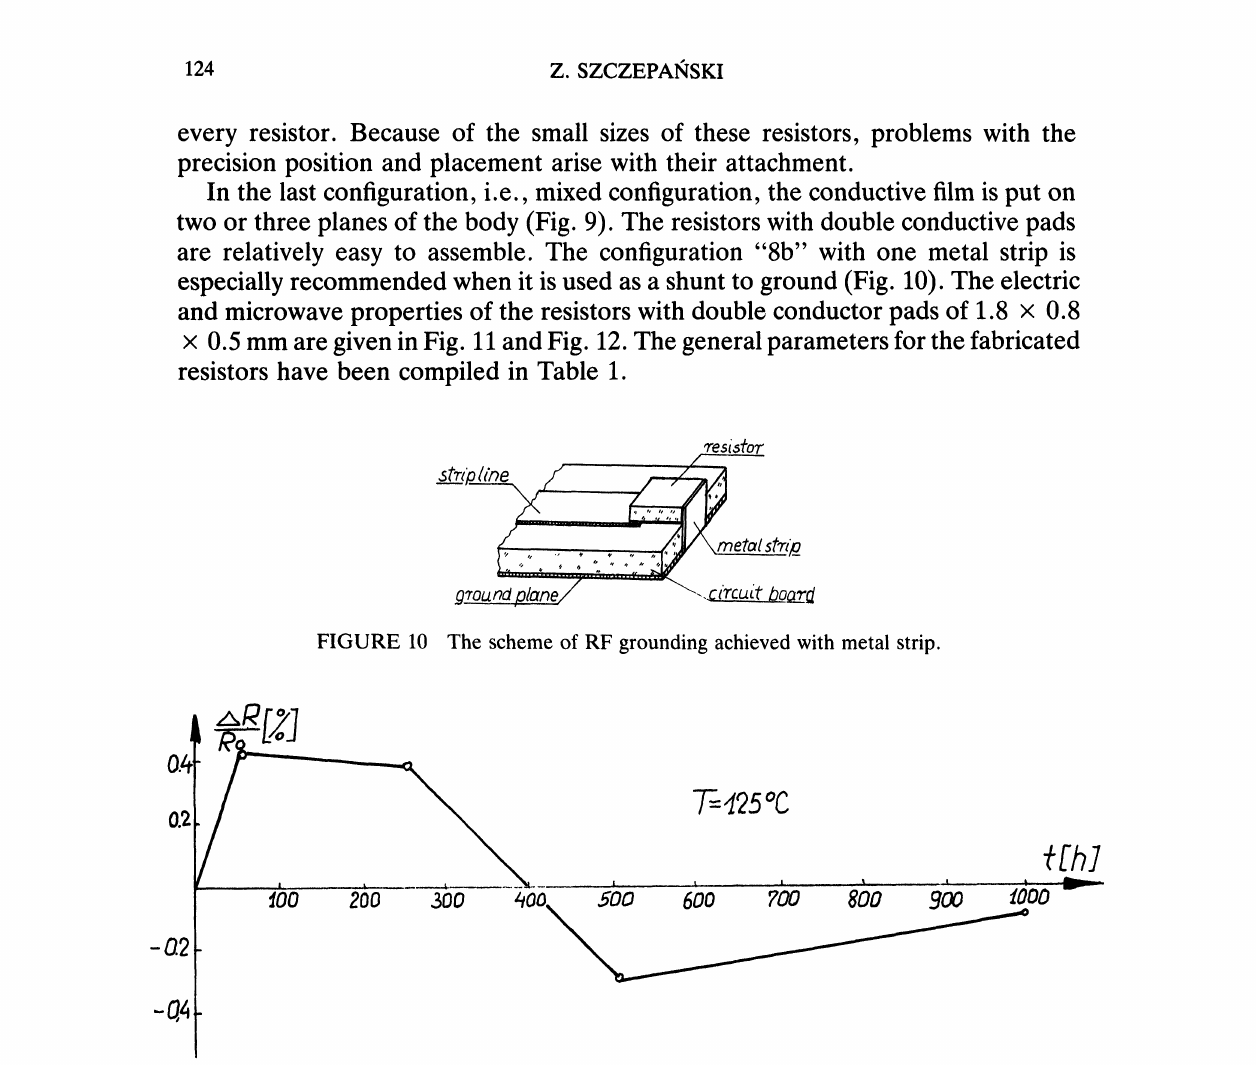
FIGURE 11 Long-term stability for mixed resistor configuration.